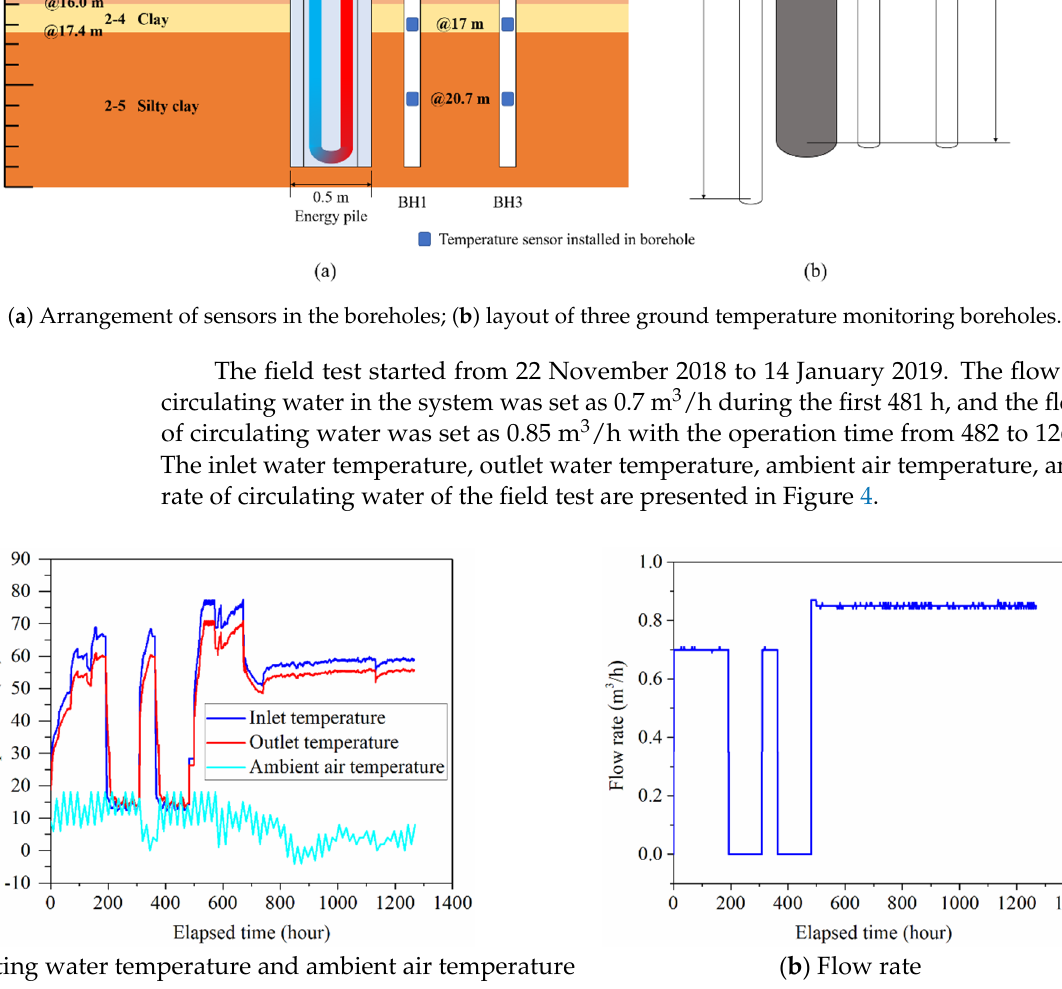
Figure 4. Circulating water temperature and ambient air temperature and flow rate of field test.